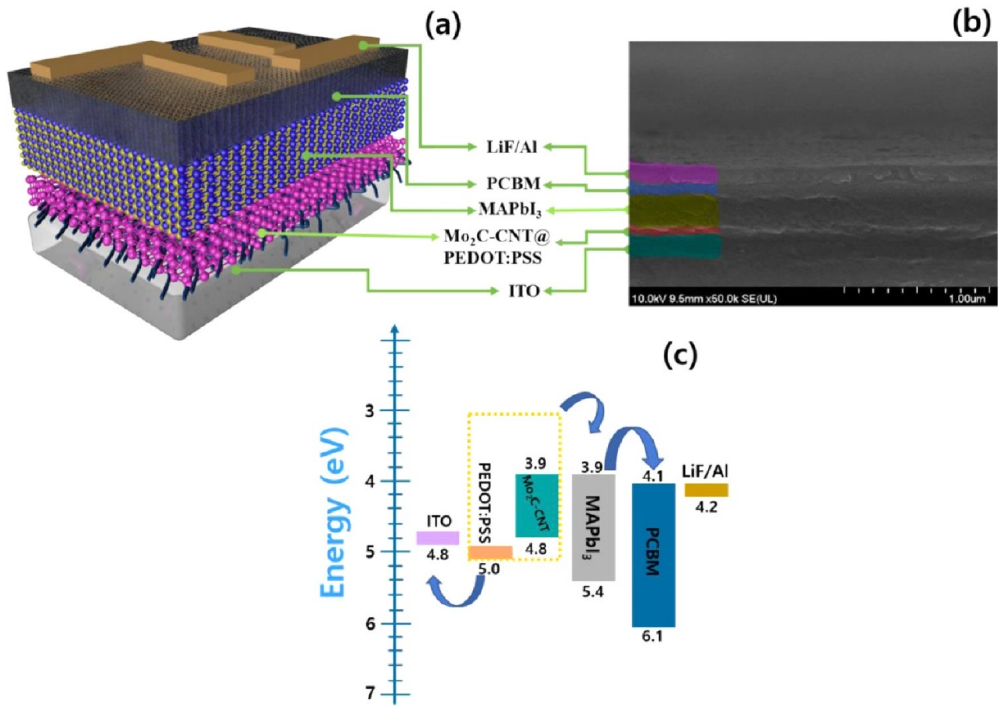
Figure 8. ( a ) Device architecture of the prepared ITO/HTL/CH 3 NH 3 PbI 3 /PCBM/LiF/Al prototype using Mo 2 C-CNTs @ PEDOT: PSS HTL and ( b ) FESEM cross-sectional image; ( c ) Energy level diagram for ITO/Mo 2 C-CNTs @ PEDOT: PSS/CH 3 NH 3 PbI 3 /PCBM/LiF/Al structure. Reprinted with permission from ref. [121]. Copyright 2021 Elsevier B.V.